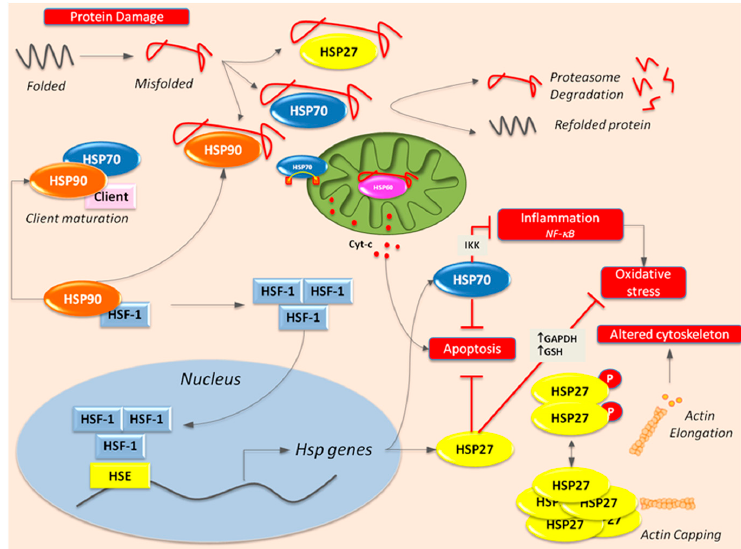
Figure 3. Cytoprotective Effects of HSPs in Diabetes. HSP90 binds to the transcription factor HSF1 and keeps it in an inactive state. If HSP90 is required elsewhere, free HSF1 moves to the nuclei and induces HSP transcription. HSP90 facilitates the maturation of several proteins, known as HSP90 “clients”. HSPB1/HSP27 forms high molecular weight multimers that stabilize the cytoskeleton, but the phosphorylated form loses its actin-capping activity. HSP60 is located in the mitochondria and HSP70 shuttle cytosolic protein to the mitochondria. Diabetes causes cell damage by inducing oxidative stress, inflammation, protein damage, cytoskeleton remodeling, and apoptosis (red squares). Diabetes-induced misfolded proteins either are rescue by HSPs or undergo proteasome degradation. Besides favoring protein refolding, HSPB1/HSP27 prevents apoptosis and reduces oxidative stress (red T symbols) by increasing both glutathione (GSH) levels and glyceraldehyde 3-phosphate dehydrogenase (GAPDH) activity. HSP70 inhibits apoptosis and reduces NF- κ B-dependent inflammation (red T symbols) with consequent reduction of oxidative stress. At variance with microvascular complications, most HSP (HSPC/HSP90, HSPA/HSP70,